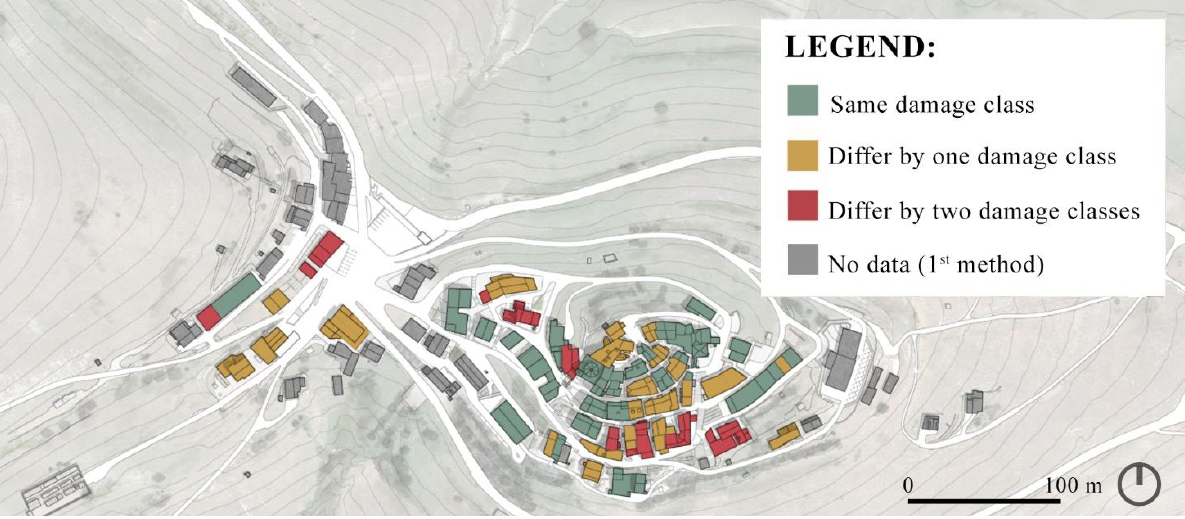
Figure 11. Graphical comparison between the two DDE